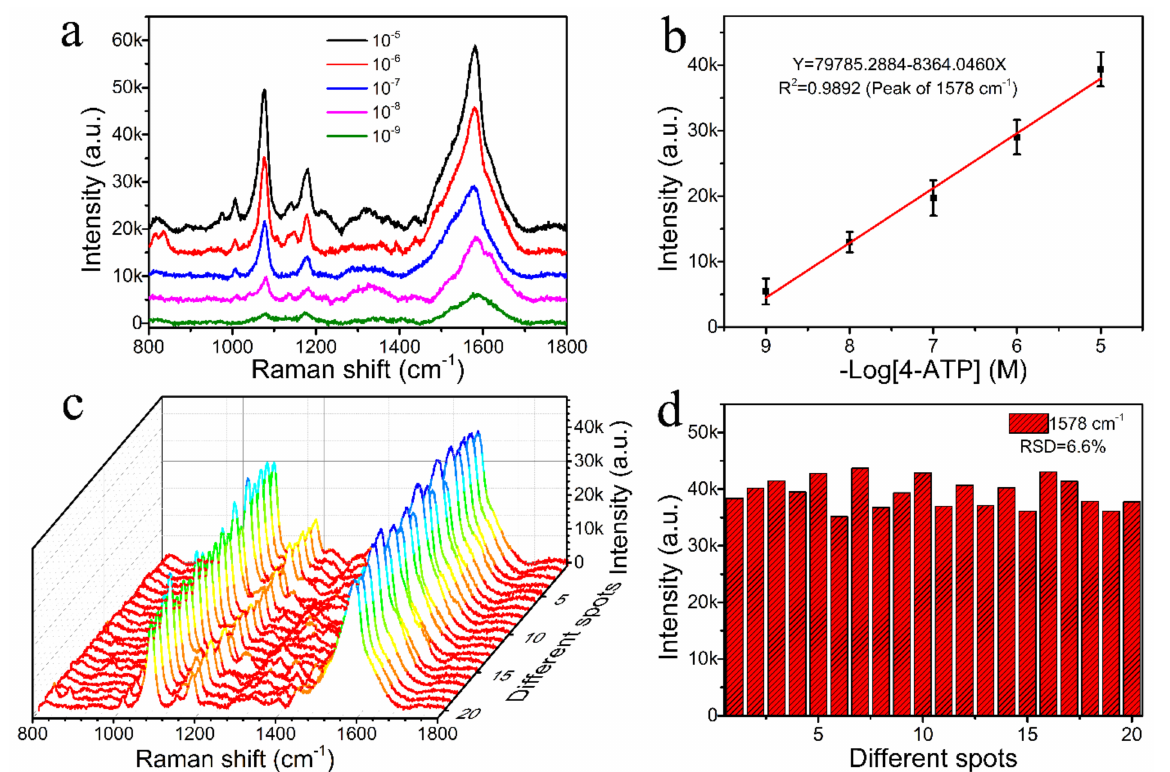
Figure 6. ( a ) SERS spectra obtained by employing 10 − 5 to 10 − 9 M of 4-ATP on the hydrophobic CFP@PDA@AuNPs substrate. ( b ) Linear fit diagram between the Raman intensity of the 4-ATP at 1075 cm − 1 and the negative logarithm of the sample concentration. ( c ) Waterfall plots of 4-ATP (10 − 5 M) SERS signals recorded from 20 selected locations on the hydrophobic CFP@PDA@AuNPs substrate. ( d ) Corresponding histograms of peak intensity at 1075 cm − 1 for the